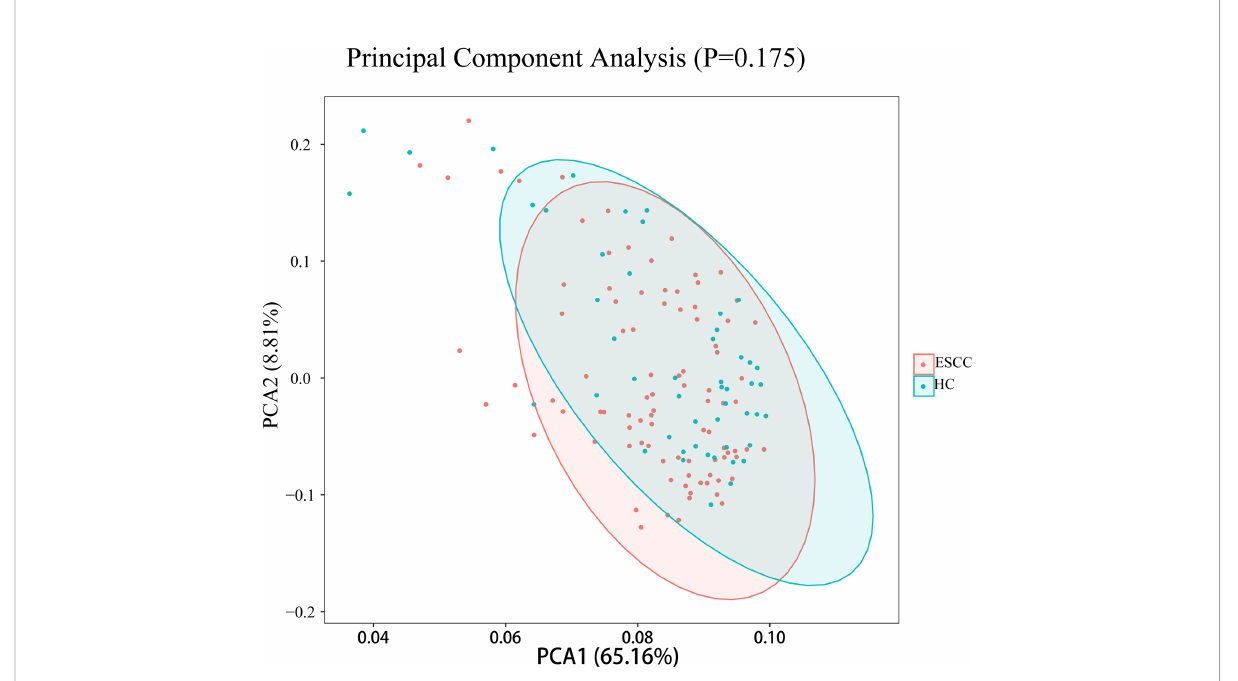
FIGURE 2 PCoA plots for saliva samples from the ESCC and healthy control (HC)